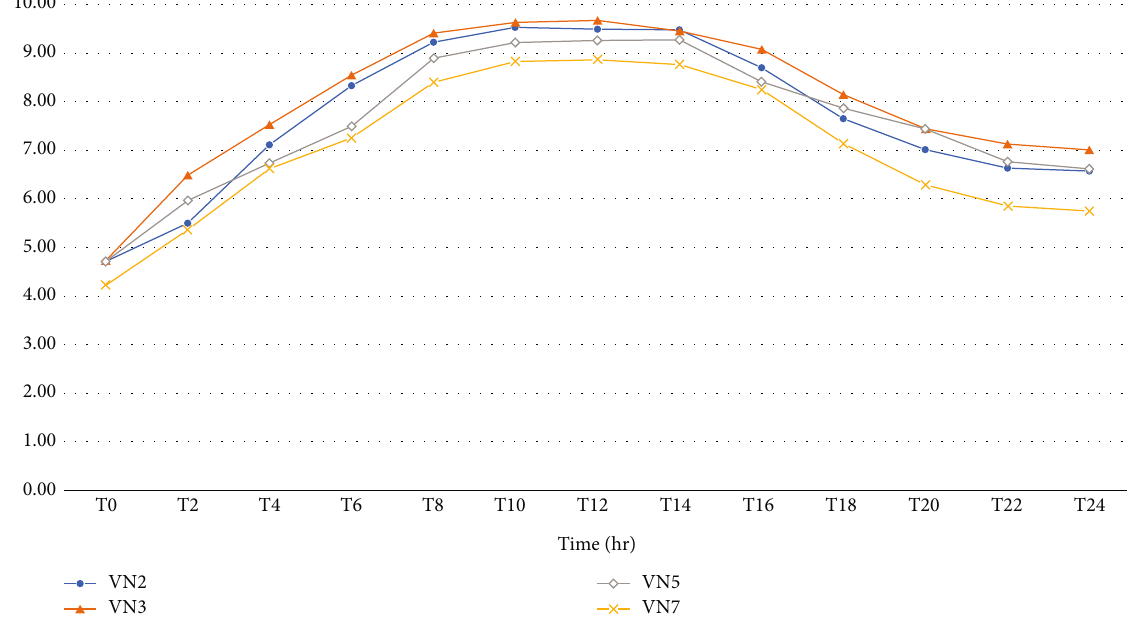
Figure 3: Growth curve of the isolated bacteria for